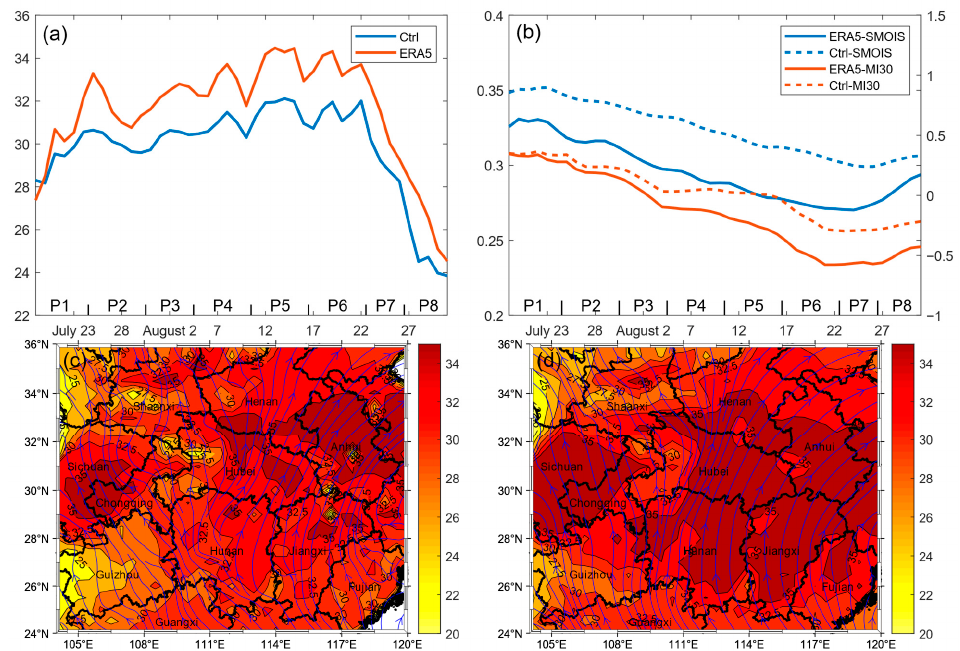
Figure 9. ( a ) Area average T max of South China in the control run (blue line; ◦ C) and ERA5 reanalysis data (red line; ◦ C). ( b ) Area average soil moisture (SMOIS) and MI30 in the control run (red line for SMOIS; m 3 m − 3 , purple line for MI30) and ERA5 reanalysis data (blue line for SMOIS; m 3 m − 3 , yellow line for MI30). ( c , d ) Average T max (shading; ◦ C) and wind at 850 hPa (streamlines; m s − 1 ) in the heatwave event in ( c ) the control run and ( d ) ERA5 reanalysis